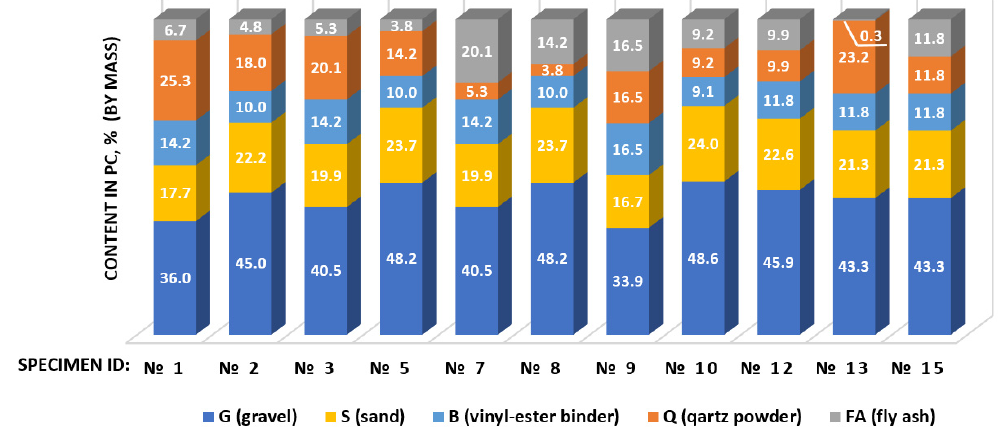
Figure 5. Vinyl-ester concretes compositions (% by mass) based on the statistical Box design (experimental CCD design of three factors expressed as the mass ratios of components: B/(G + S) in range of 6.0–10.0 , B/(FA + Q) in the range of 0.4–0.6, and FA/(FA + Q) in the range of 0.0–1.0).